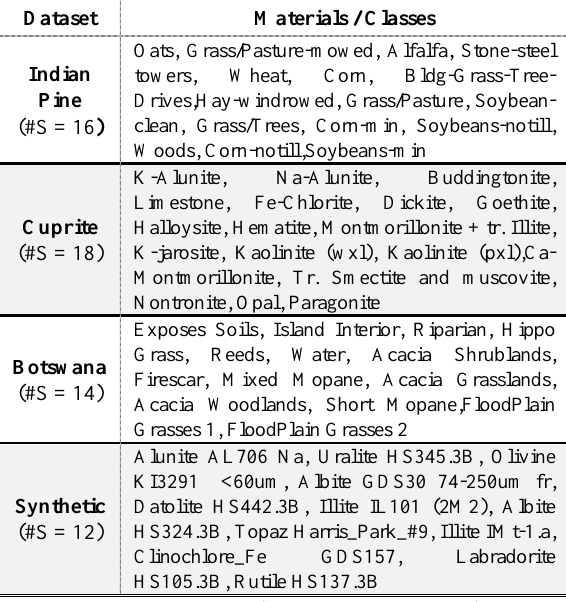
Table 1. Signal sources (i.e., substances/classes) of the hyperspectral datasets used to evaluate the VD estimation methods {#S: Number of Signal